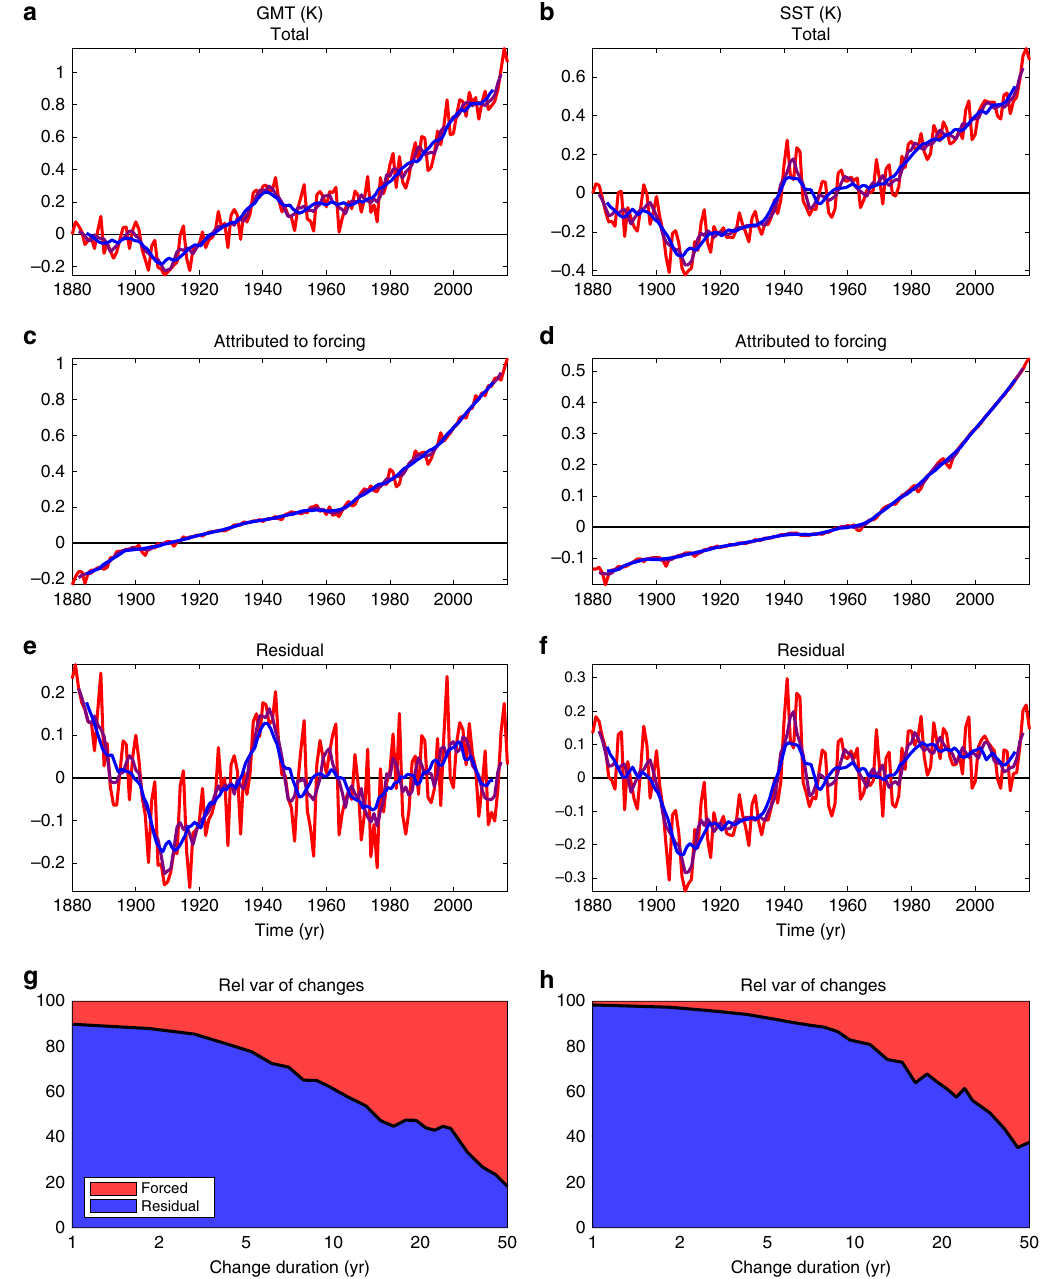
Fig. 1 Attribution of observed global-mean surface air temperature (GMT) and sea surface temperature (SST). a , b The total (red) annual, (purple) 5-year and (blue) 10-year variations in GMT and SST measured from 1880 are decomposed (through an attribution method based on multivariate linear regression onto volcanic eruptions, aerosol concentration, and greenhouse gas concentration 2 ) into c , d a forced contribution and e , f a residual. g , h Relative variance of forced and residual GMT and SST changes as a function of the duration of these changes. Variations are mainly controlled by the residual, rather than forcing on interannual to decadal timescales. The observed GMT are from NASA GISS temperature data, and SST is from the